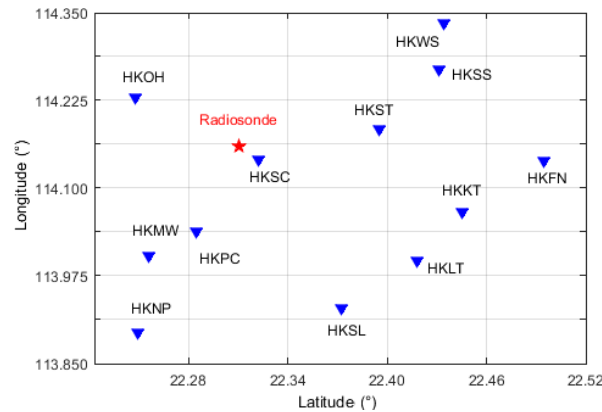
Figure 1. Distribution of the Hong Kong SatRef sites (blue trian- gles) inside the tomography horizontal grid (black dotted lines) and the King’s Park radiosonde station (red star). The region was dis- cretized into an 8 × 5 × 17 cell grid for the GPS water vapor to- mography. The layer heights are 0, 400, 800, 1400, 2000, 2600, ..., 8600m from ground to water vapor layer